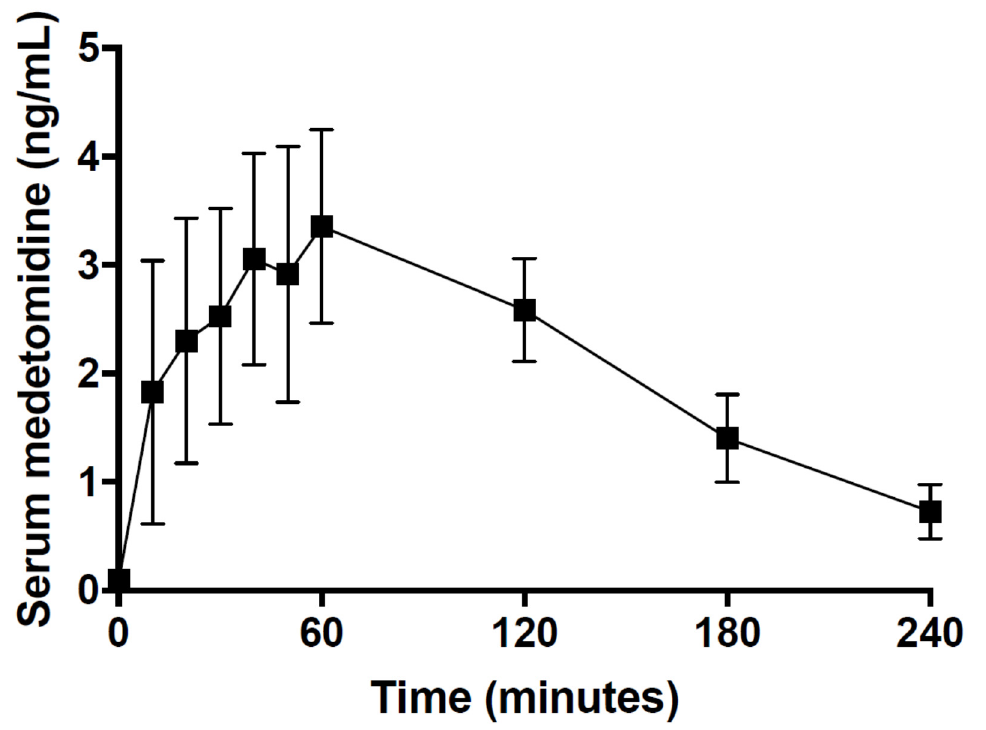
Figure 2. Time course of mean (±standard deviation) serum medetomidine concentration after subcutaneous administration of 0.05 mg/kg medetomidine in six Sprague-Dawley rats.